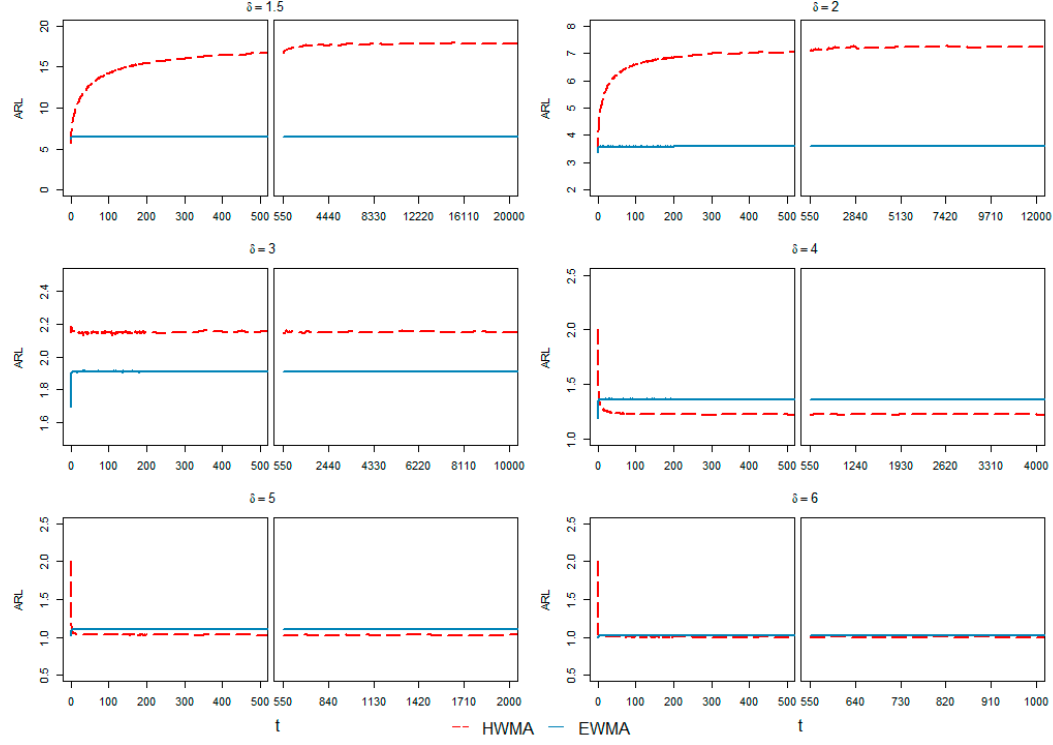
Figure 11. CED curves for the HWMA and EWMA charts under moderate to large shifts at 𝜆 = 0.5 with respect to time points (𝑡) .